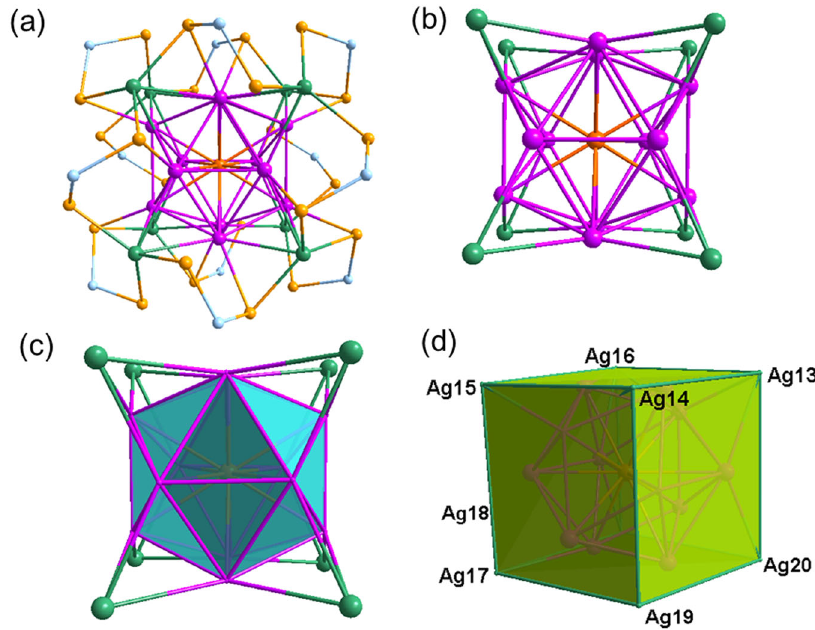
Fig. 4 Molecular structure of 3( Pn ). a Total structure of [PdAg 20 {Se 2 P(O i Pr) 2 } 12 ] ( 3 ( Pn )) (isopropoxy groups omitted for clarity), b Illustration of the Pd@Ag 20 metallic core in 3 ( Pn ) with T h symmetry, c A view of the Pd@Ag 12 centered icosahedron core with its 8 capping Ag atoms, d The centered Pd@Ag 12 icosahedron inscribed in Ag 8 cube (color code. Pd: orange red; Ag ico : pink, Ag cap : green; Se: light orange; P: light